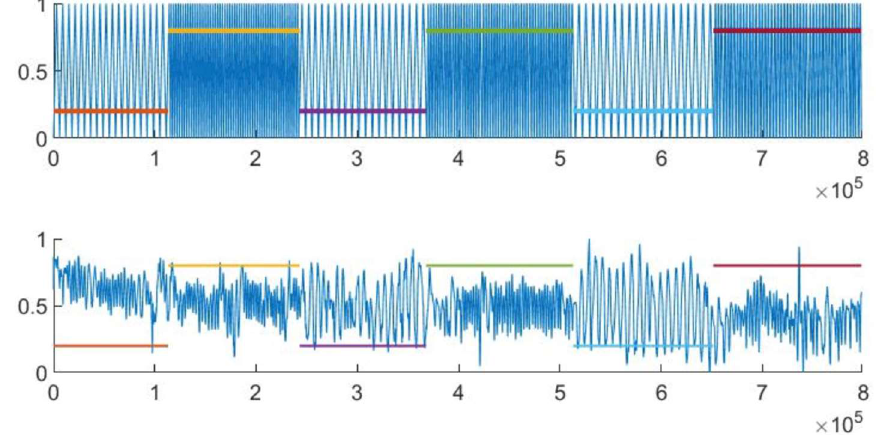
Figure 10. Top plot: Breathing frequency of the virtual human during a single pilot trial. Bottom plot: Example breathing recording from a human participant.